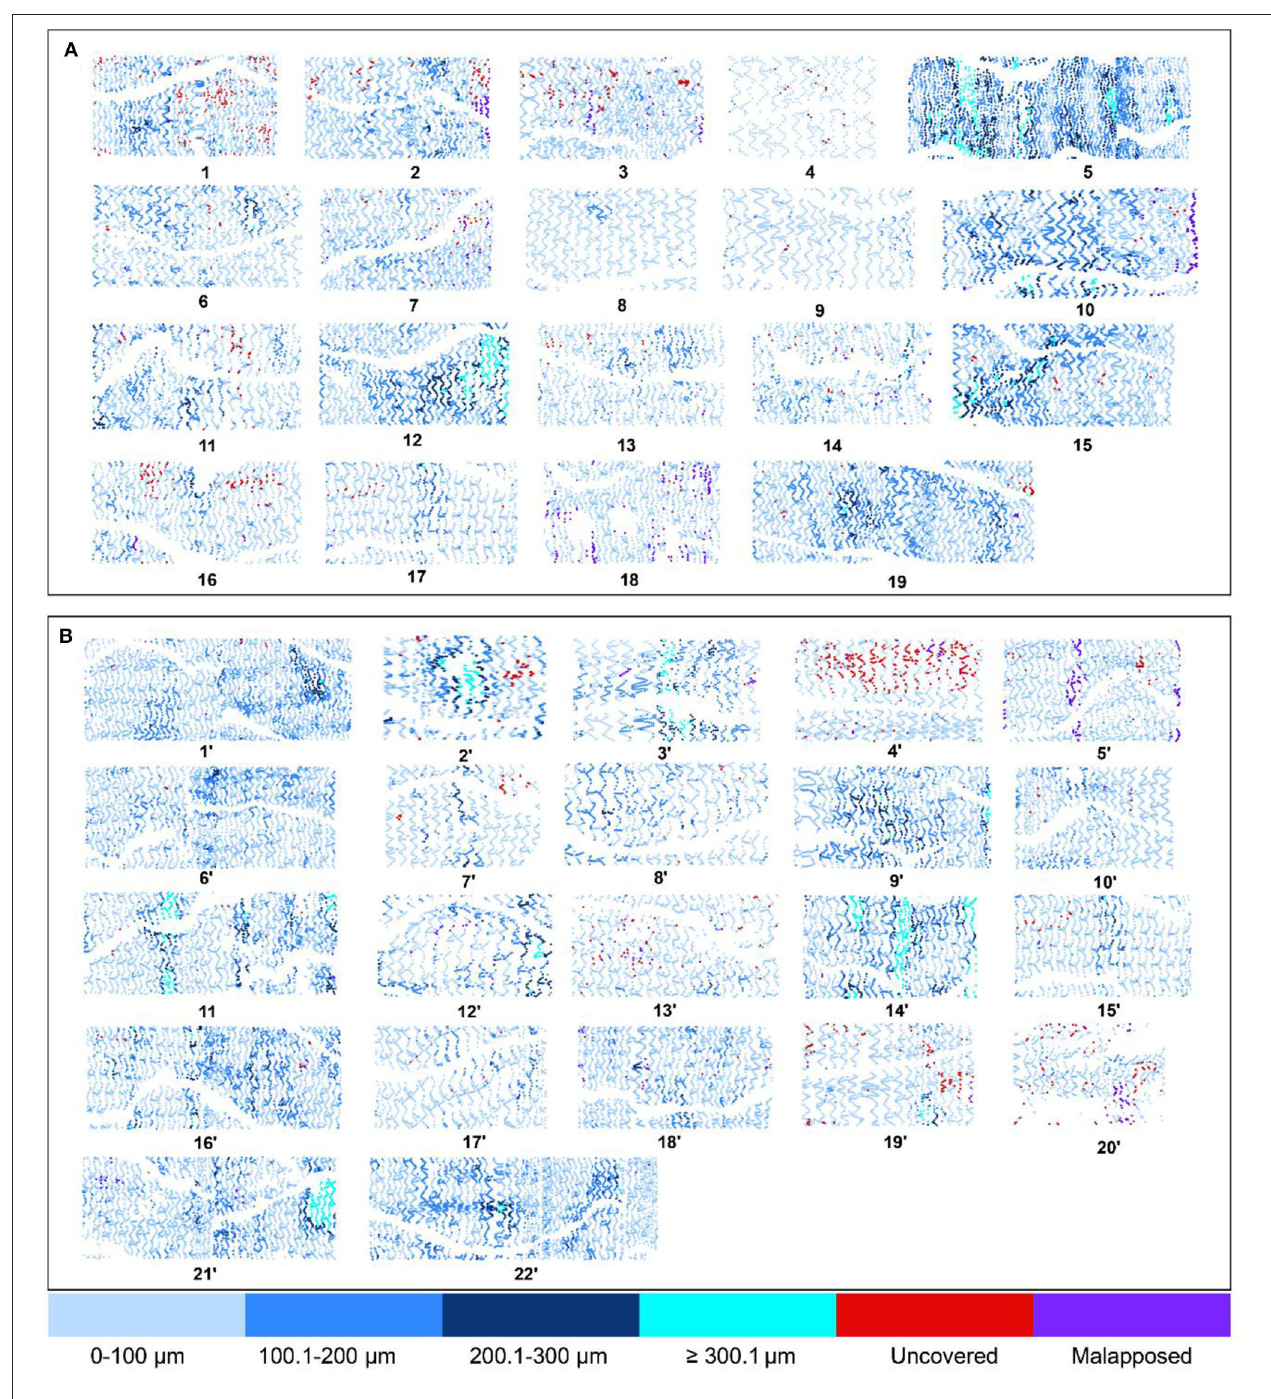
FIGURE 3 | The neointimal thickness and coverage or malapposition of stent status in individual stents at 6 months. The spread-out sheets demonstrate the coverage stent status of individual stents at 6 months. (A) Demonstrates the coverage and malapposition status of the Firehawk stents, while (B) demonstrates the coverage and malapposition status of the Xience stents. Struts are color-coded according to their coverage status. Uncovered struts are depicted as red; malapposed struts are depicted as purple; and covered struts are depicted as blue and cyan, with deepening color of blue indicative of a thicker neointima (light blue color indicates a neointimal thickness ≤ 100 µ m, sustained blue indicates a neointimal thickness 100.1–200 µ m, navy blue indicates a neointimal thickness 200.1–300 µ m, and cyan indicates a neointimal thickness ≥ 300.1 µ m). The x-axis indicates the position of the strut in the individual cross-section ranging from 0 ◦ to 360 ◦ , whereas the y-axis represents the cross-section of the stent from distal (left) to proximal (right).